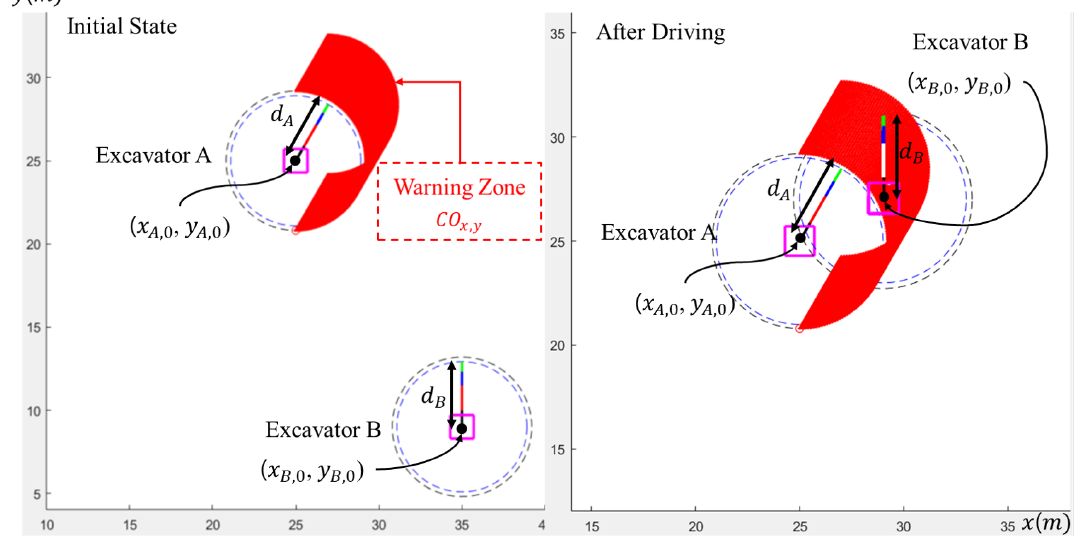
Figure 6. Results of the Simulation: The CO x , y , warning zone is generated, which indicates where Excavator B should avoid during movement of the